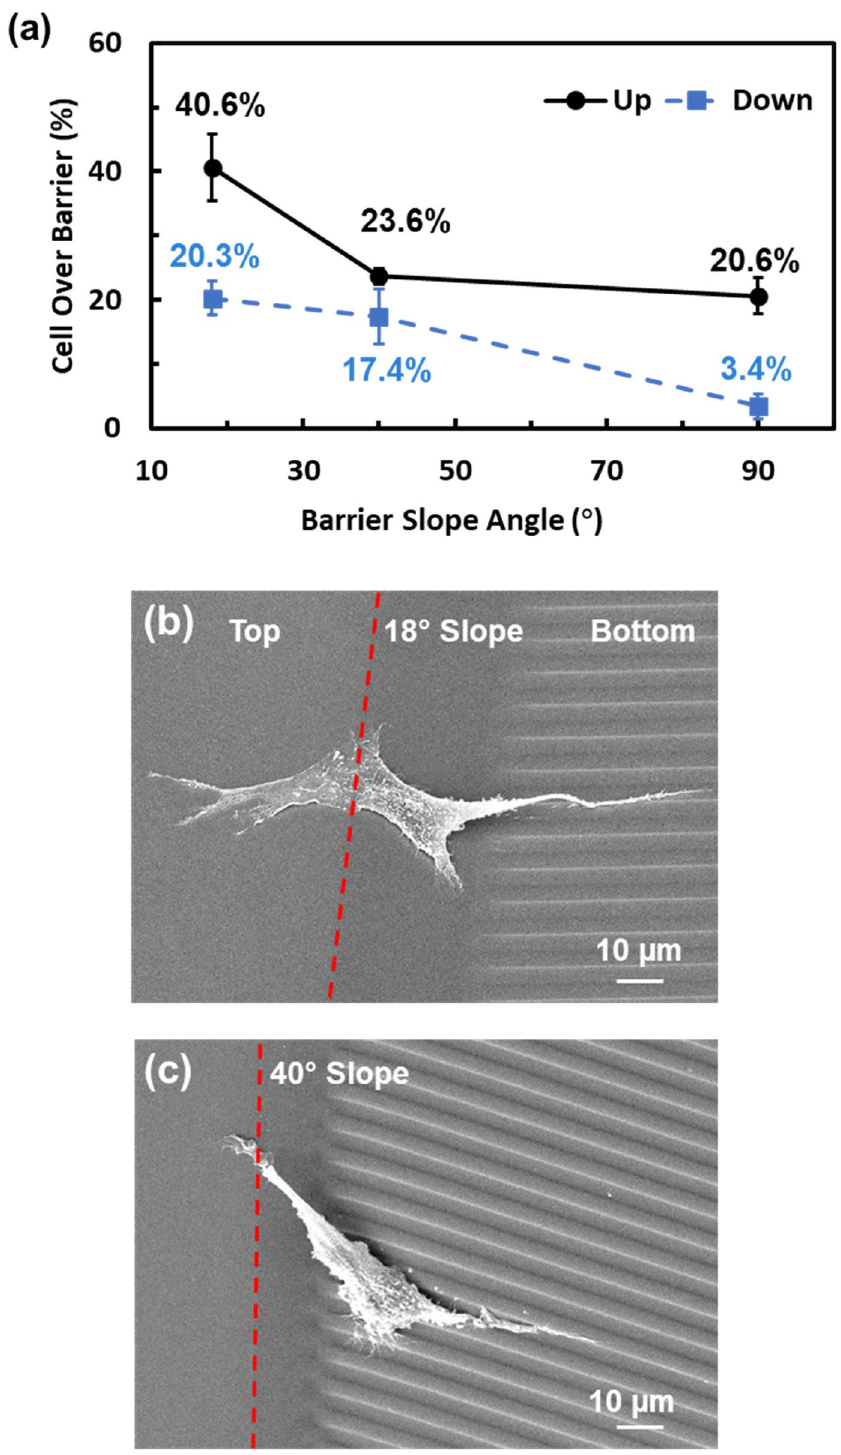
Figure 9. ( a ) Proportion of MC3T3 cells climbed up and down 10 µm tall sloped barriers with slope varying from 18° to 90°. ( b ) Micrographs of MC3T3 cells on 18° and ( c ) 40° slope, 10 µm tall barriers. Red dash lines indicate boundaries of barrier and sloped sidewall. All the data were obtained over a 16 h time-lapse imaging